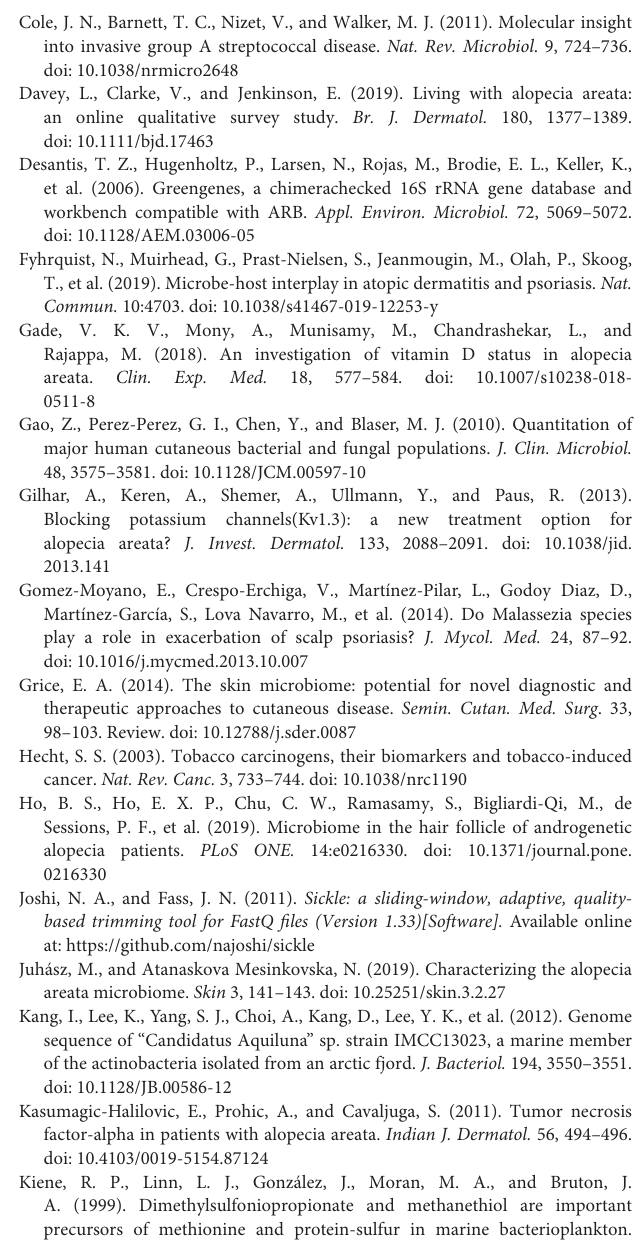
Figure S1 | Mean values (mean proportion, %) and STAMP extended error bar relative to the ten statistically significant pathways in AA and healthy sample comparison. Extended error bar plot for all FDR statistically significant pathways between the dermis microbiome of AA (orange) compared to healthy (light blue) groups. P-values have been obtained two tailed Welch’s t-test (corrected by using Benjamini-Hochberg